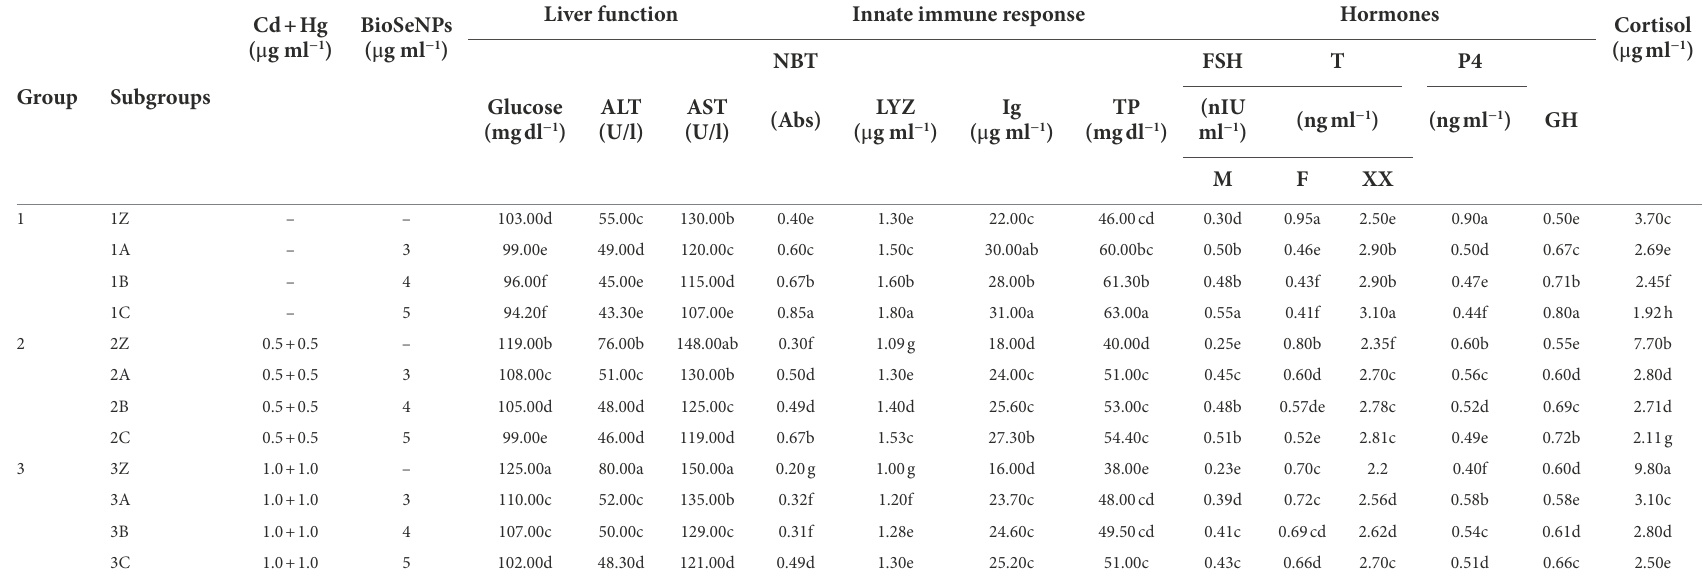
TABLE 3 Serum biochemical parameters, immune activity and hormonal levels of Nile tilapia ( Oreochromis niloticus ) fish subjected to heavy metals, mercury (Hg) and cadmium (Cd), and treated with the biosynthesized selenium nanoparticles (BioSeNPs) during the 10-week experimental period.